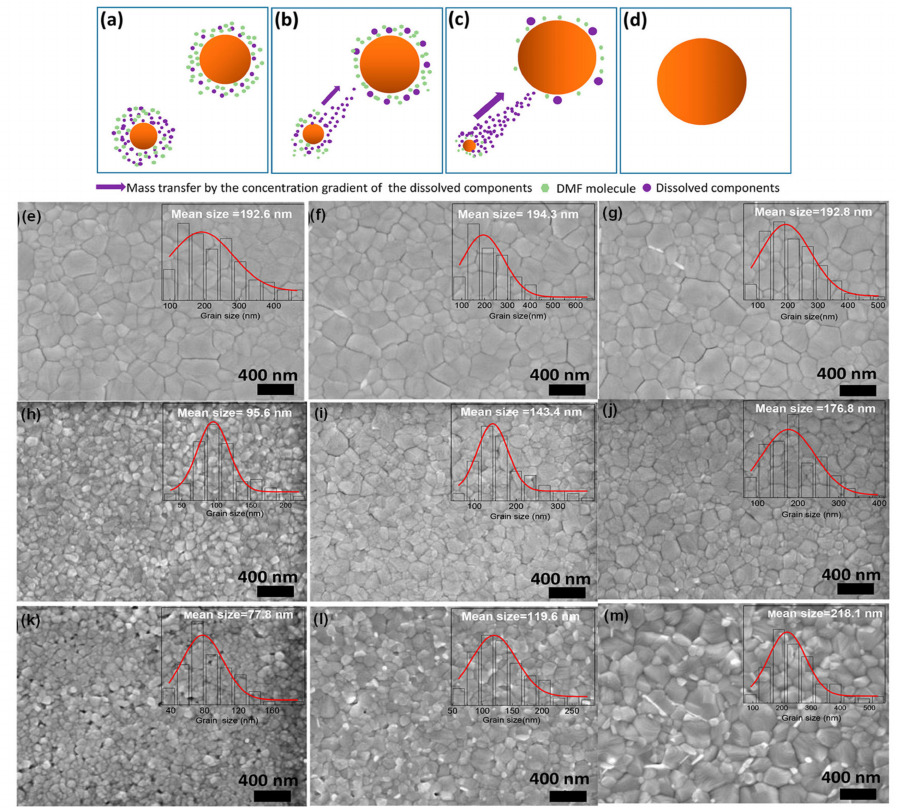
Figure 6. ( a – d ) The coarsening mechanism of perovskite grains with lengthened annealing time, as per the Ostwald ripening model: ( a ) initial stage, ( b ) early stage, ( c ) middle stage, ( d ) final stage. ( e – g ). SEM images of the perovskite films crystallized at 100 ◦ C for long annealing times after